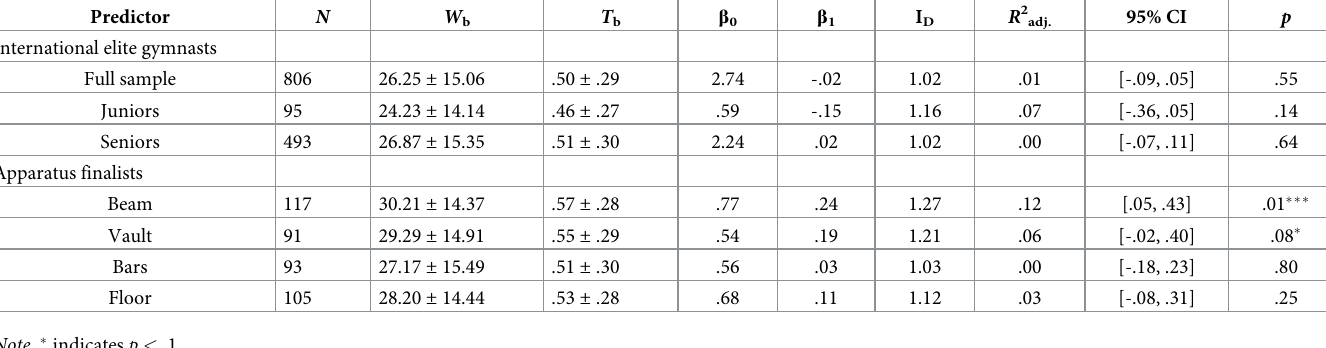
Table 1. RAE according to the Poisson regression group membership by birth